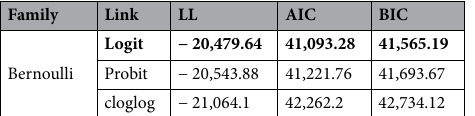
Table 2. Model comparison under different link functions.